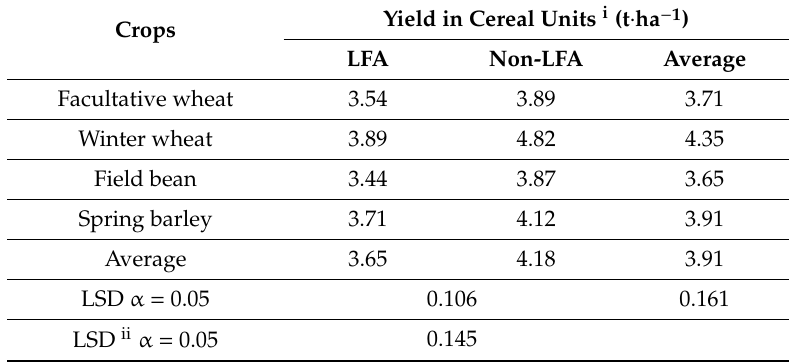
Table 2. Crop yield expressed in cereal units (t · ha − 1 ) depending on various climatic and soil conditions occurring in the LFA or non-LFA